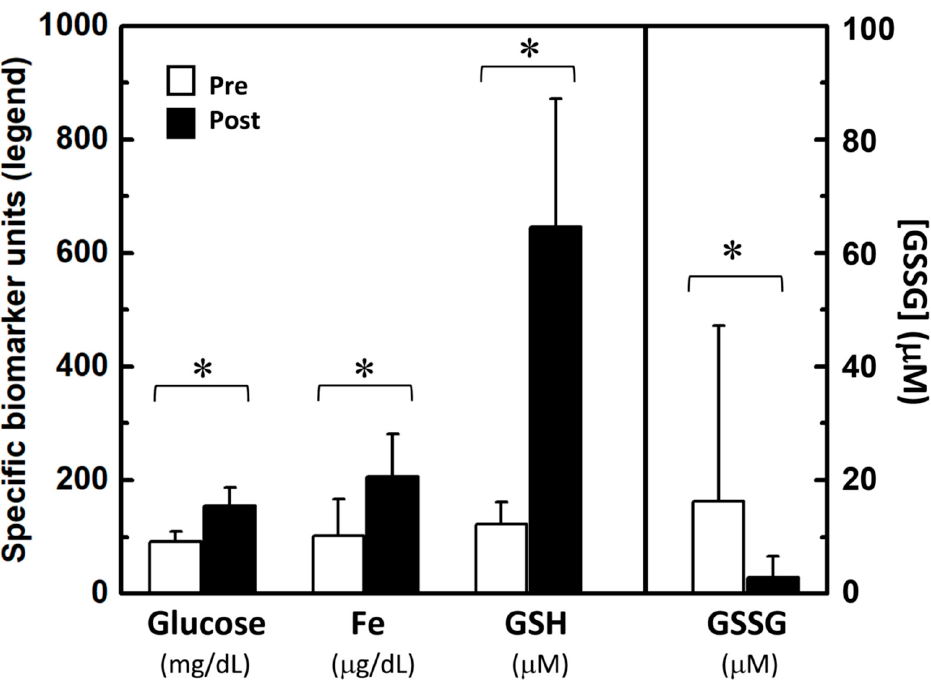
Figure 1. Concentrations of glucose, total iron (Fe), reduced and oxidized glutathione (GSH and GSSG, respectively) in plasma of novice jiu-jitsu athletes before (pre) and after (post) their first official competitions. (* p < 0.05; N = 13).